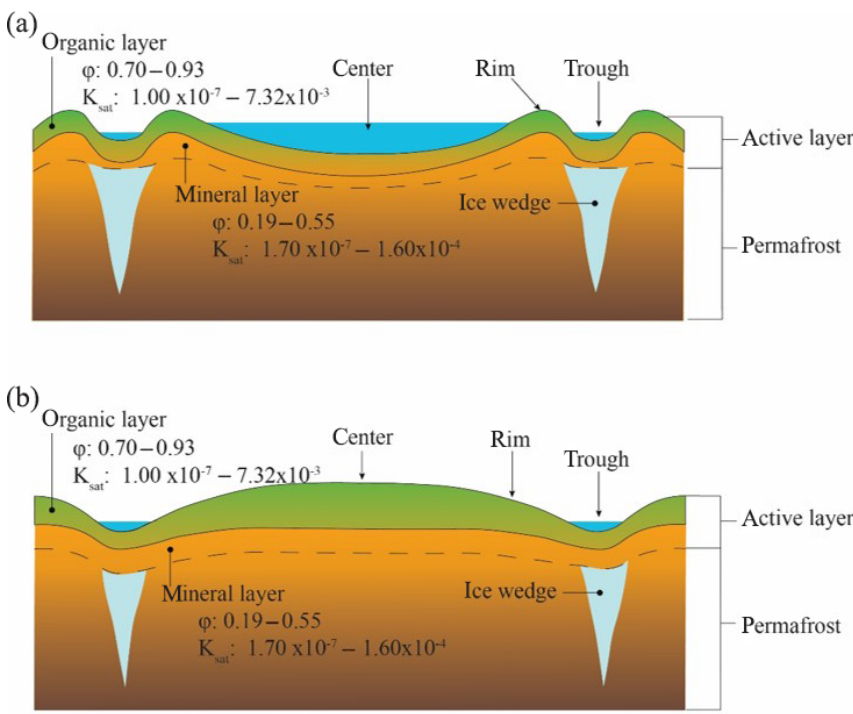
Figure 1. Conceptual diagram of a low-centered polygon (a) and a high-centered polygon (b) . Porosity and Ksat (ms − 1 ) values from the literature (see Supplement, Table S1: Atchley et al., 2015; Beringer et al., 2001; Hinzman et al., 1991; Lawrence and Slater, 2008; Letts et al., 2000; Nicolsky et al., 2009; O’Donnell et al., 2009; Price et al., 2008; Quinton et al., 2000; Zhang et al.,